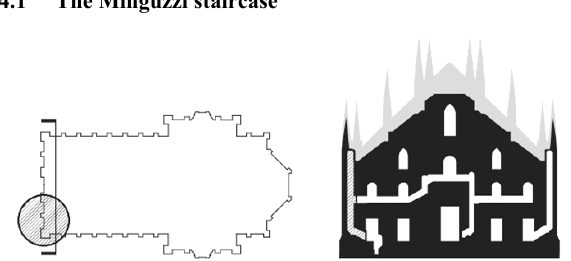
Figure 8. Location of the Minguzzi spiral staircase in the